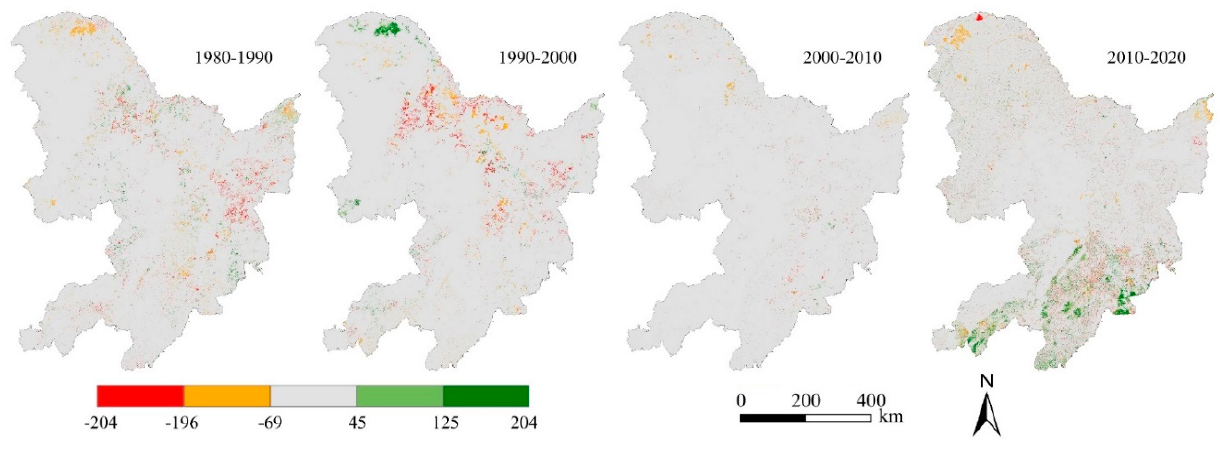
Figure 12. Stages of FCS in NCF (Mg/hm 2